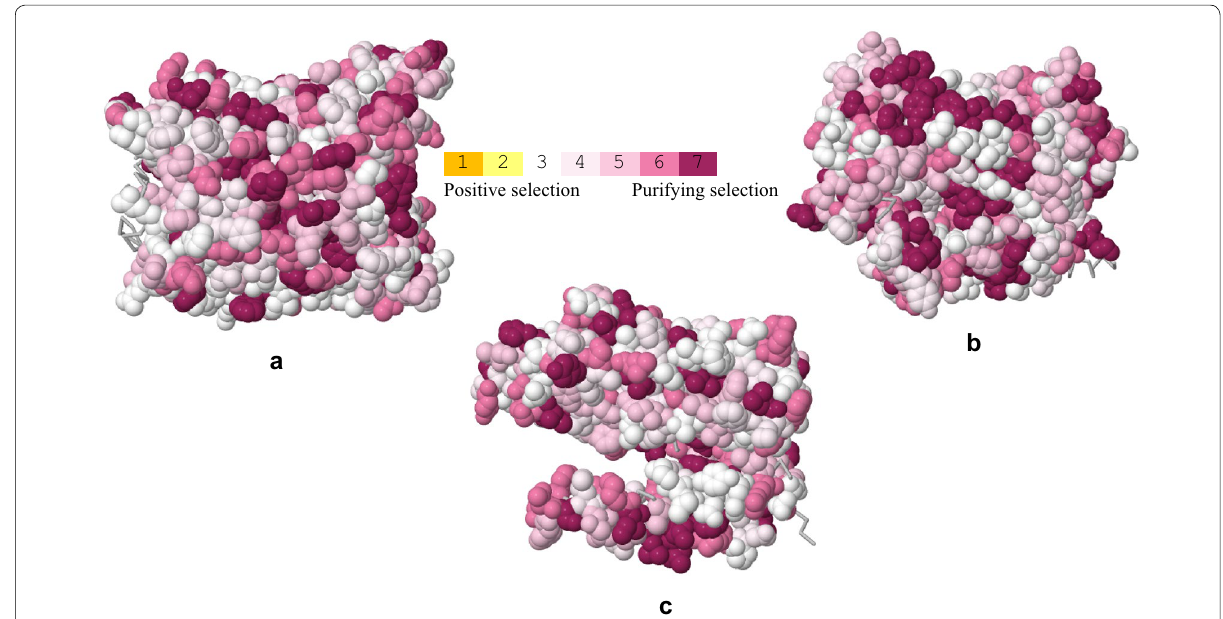
Fig. 1 Selecton results for the three mitochondrial coding genes. The amino acids of the monomer are colored by their Ka/Ks scores using the color-coding bar. Significant purifying selected sites ( p < 0.05) are colored in bordeaux (color number 7). a COX1, b COX3 and c